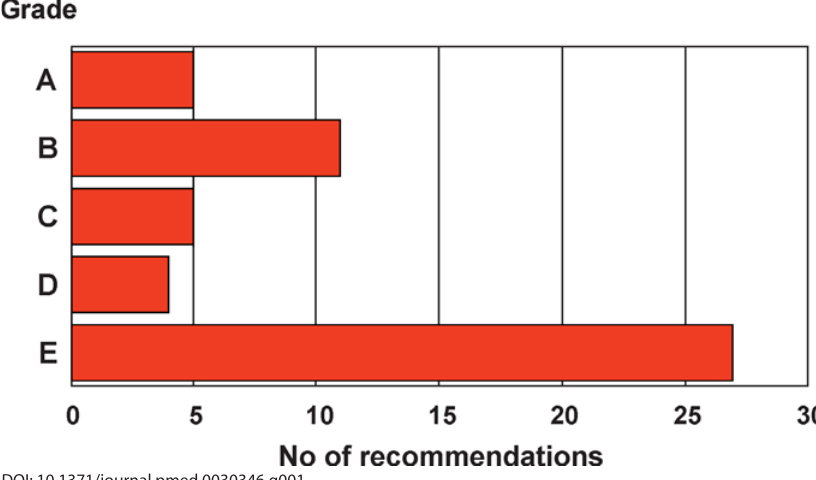
DOI: 10.1371/journal.pmed.0030346.g001 Figure 1. Number of Recommendations of Each Grade of Evidence in the Surviving Sepsis Campaign Guidelines The fi gure shows that there are more E-grade recommendations than all the other grades put together. Grading system: A, supported by at least two large randomized trials with clear results; B, supported by a large randomized trial with clear results; C, supported by small randomized trial(s) with uncertain results; D, supported by a study with nonrandomized contemporaneous controls; E, studies with historical controls, uncontrolled studies, case series, and expert